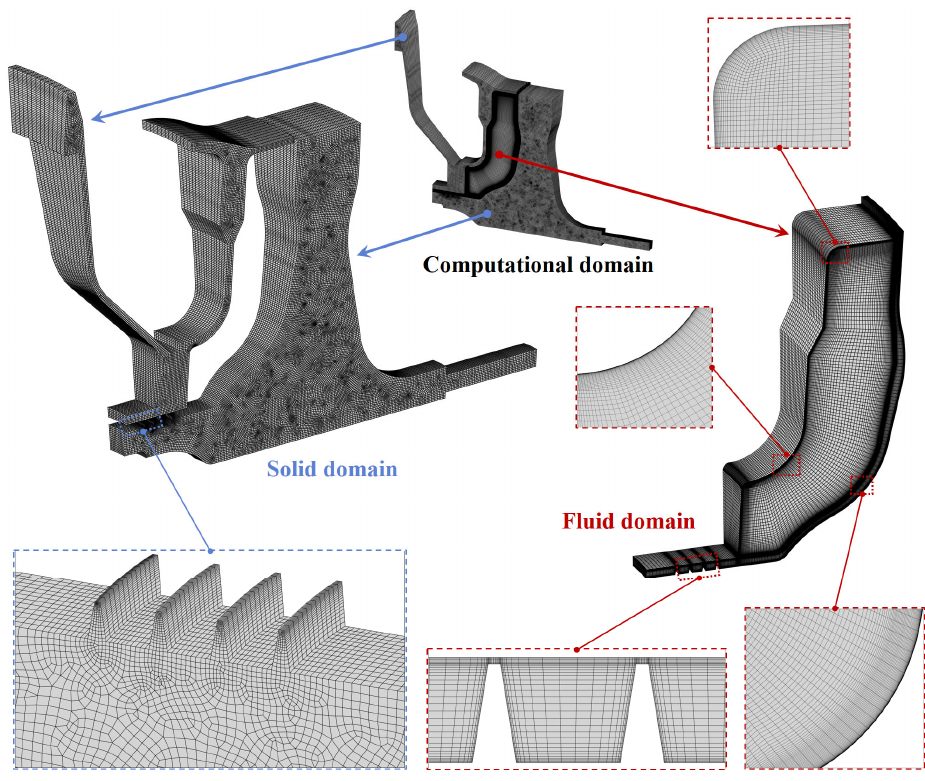
Figure 6. Computational grids.